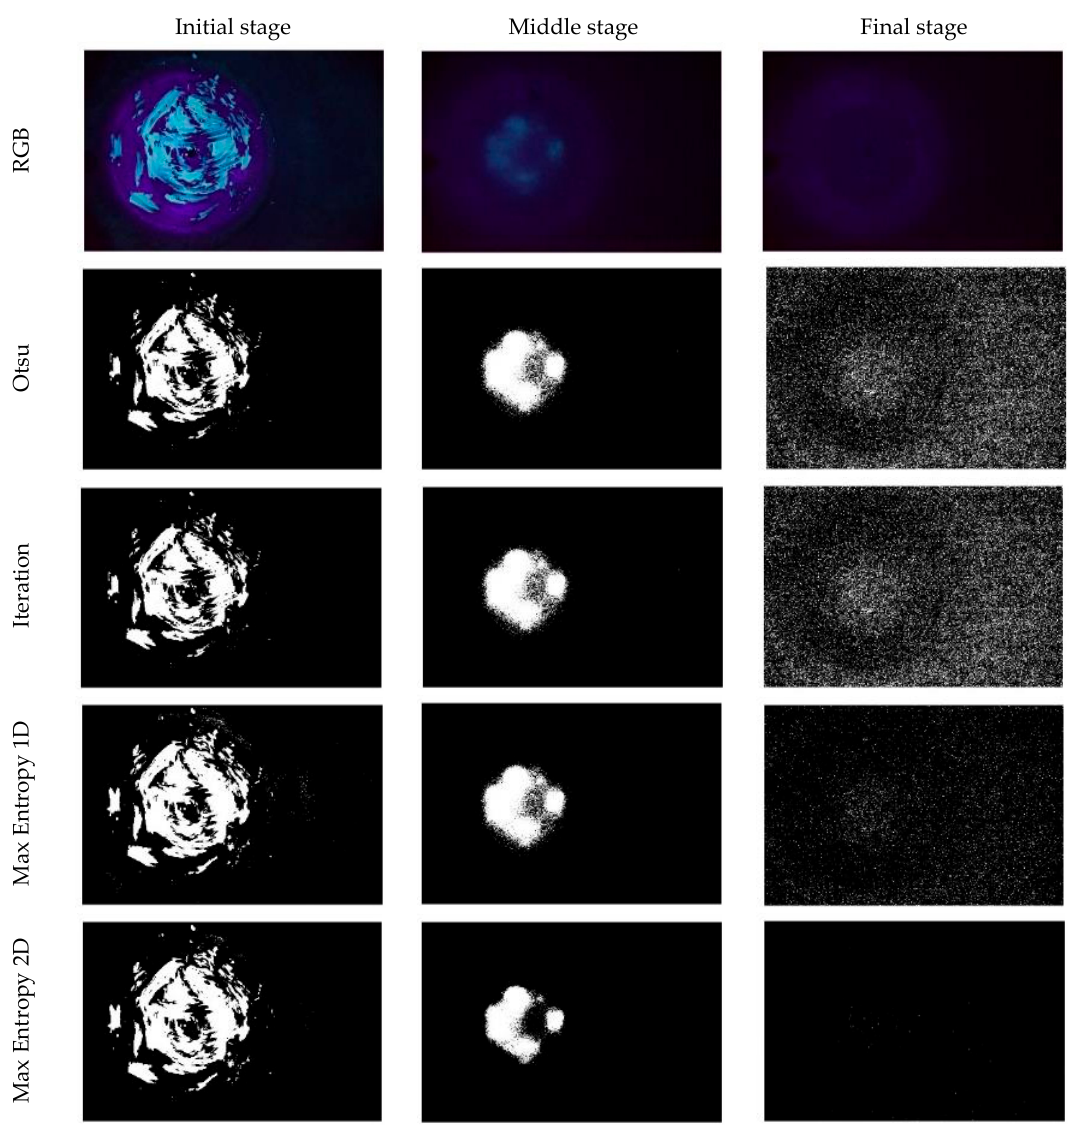
Figure 12. Thresholding methods comparison.